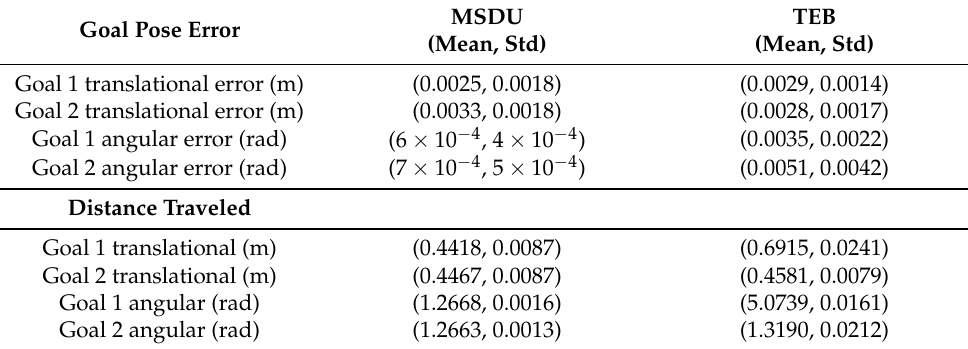
Table 8. Repeatability of performance of MSDU and TEB on short